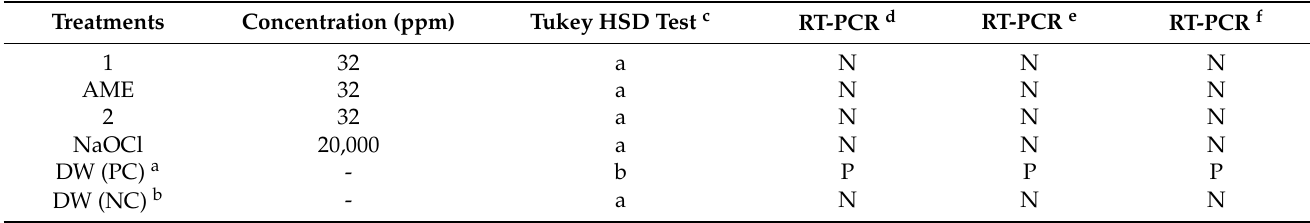
Table 2. Qualitative evaluation of the final viability of the